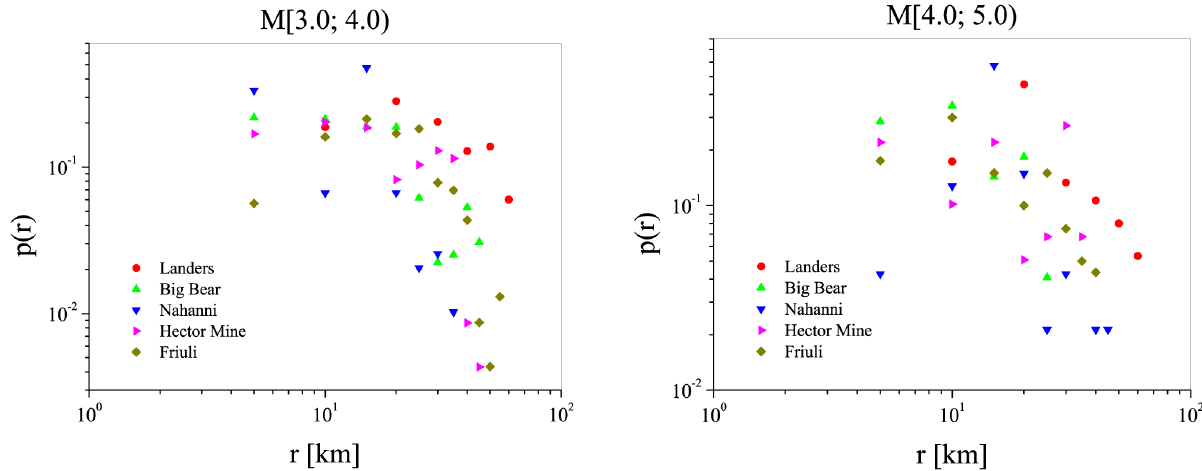
Figure 5. Frequency distribution p ( d ) versus main shock-aftershock distance r , for the selected earthquakes in varius magnitude intervals.